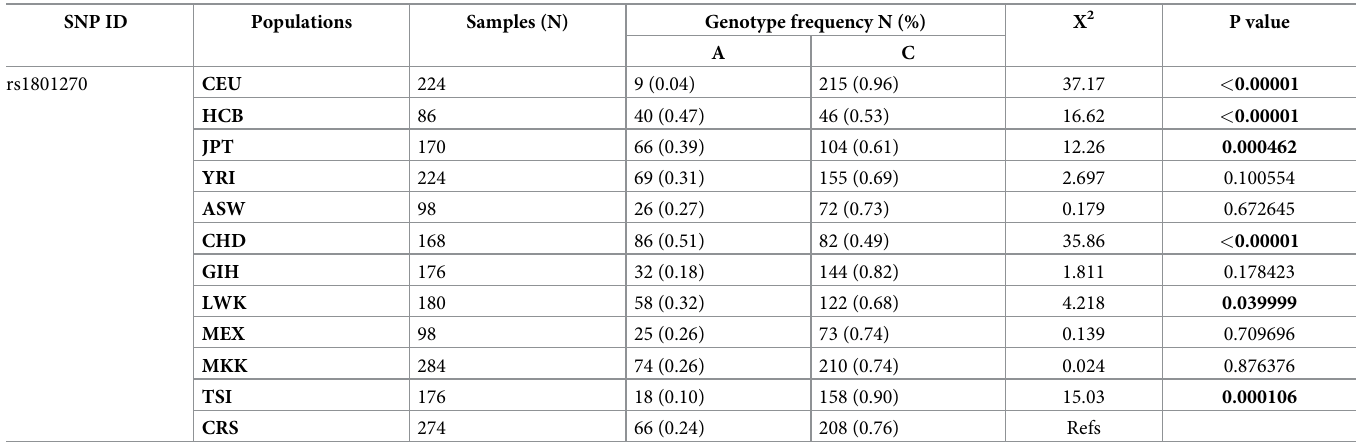
Table 9. Comparison of P21 variant frequency in other